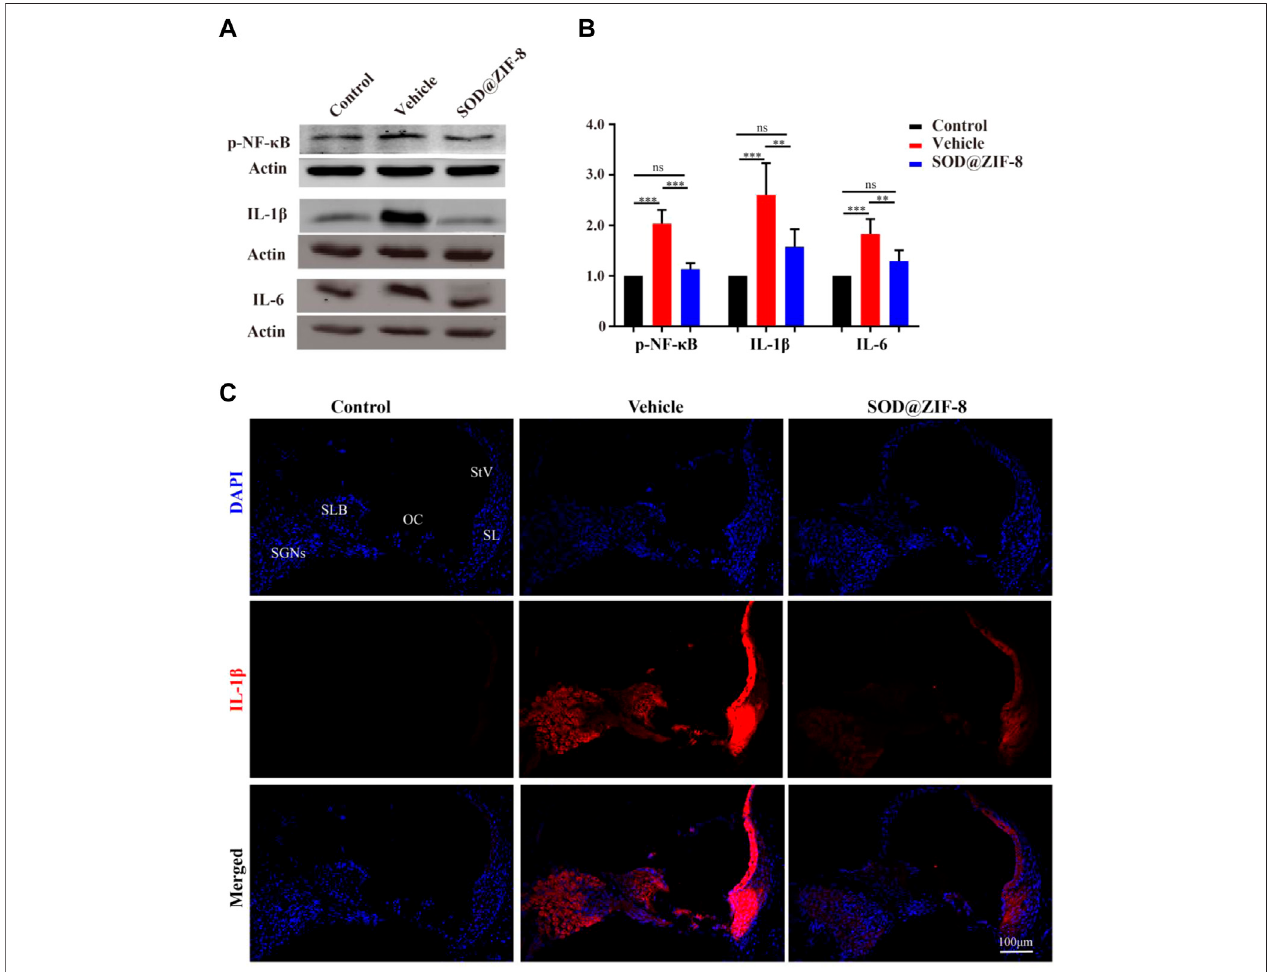
FIGURE 6 | Superoxide dismutase (SOD)@zeolite imidazolate framework-8 (ZIF-8) administration counteracted in fl ammation in the cochlea caused by noise exposure. (A,B) Protein expression level and statistical analysis of phosphonuclear factor kappa B (p-NF- κ B), interleukin (IL)-6, and IL-1 β in the cochleae of various groups. (C) Representative images of IL-1 staining in the middle – basal cochlear turns from three groups (StV: Stria Vascularis; SL: Spiral Ligament; SLB: Spiral Limbus; OC: Organ of Corti; SGNs: Spiral Ganglion Neurons). Data are presented as means ± standard deviation (SD) (** p < 0.01, *** p < 0.001, ns: no statistical signi fi